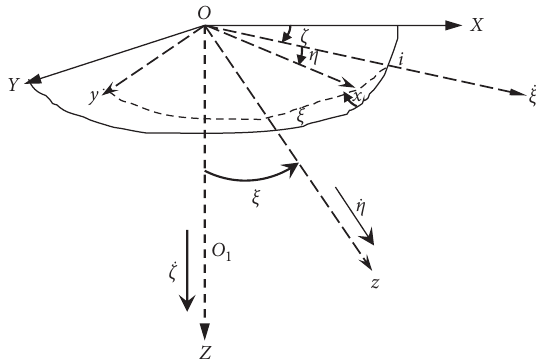
Figure 2: The rotational planes in terms of Euler’s